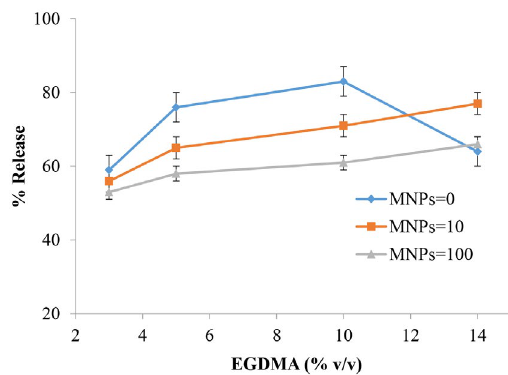
Fig. 8. Effect of EGDMA amount on the release of atorvastatin.